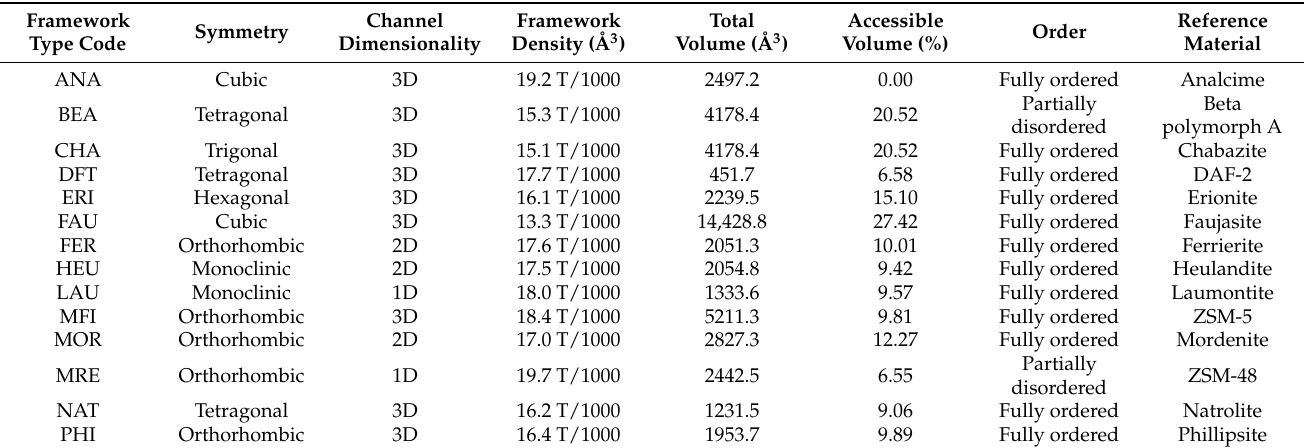
Table 5. Classification of zeolites as per their structure type